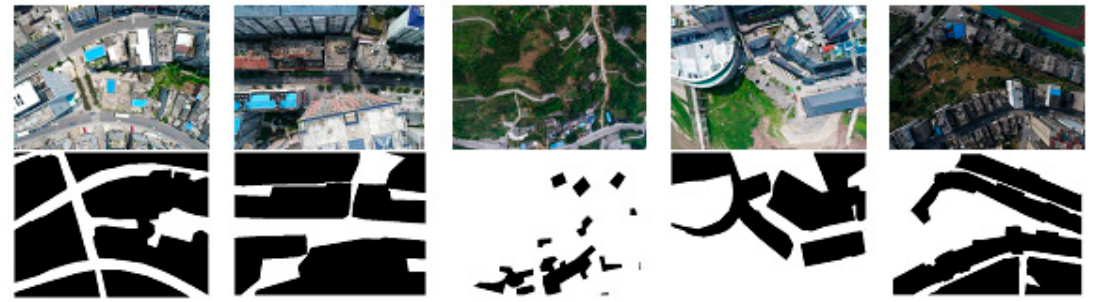
Figure 3. UAV images and their corresponding annotation images.